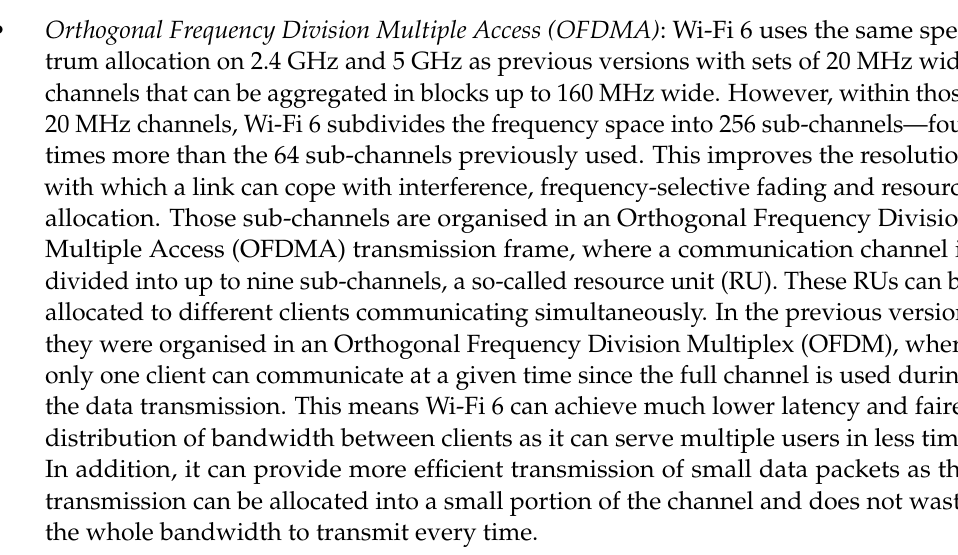
Figure 7. New Wi-Fi 6 features for capacity